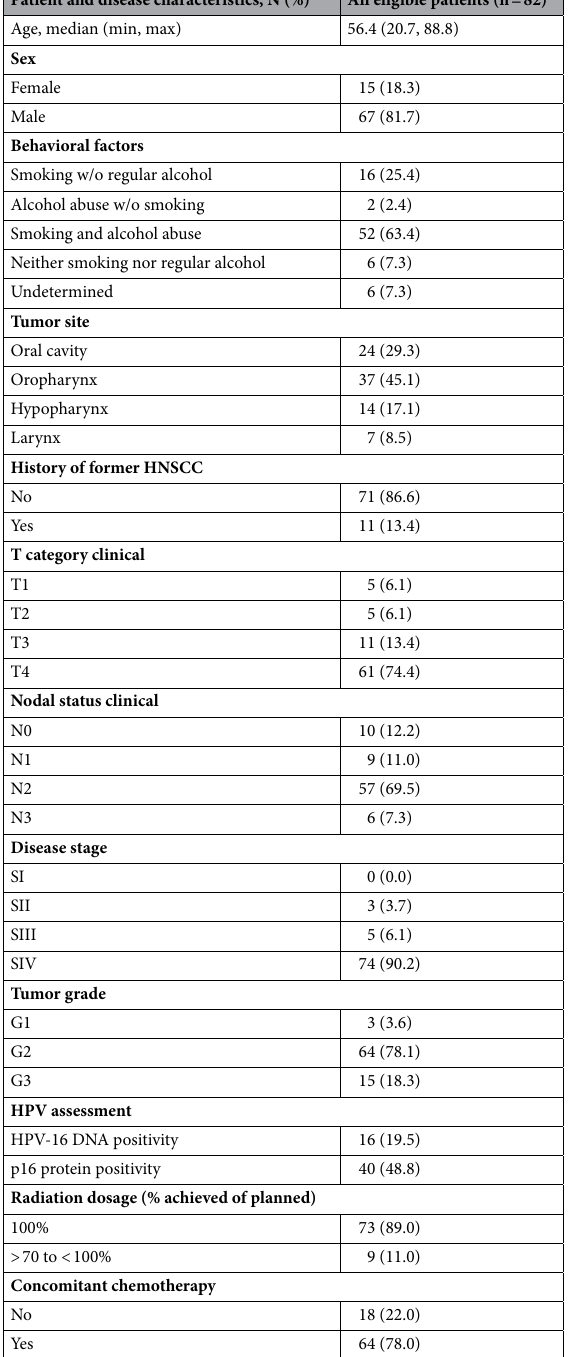
Table 1. Baseline patient and disease